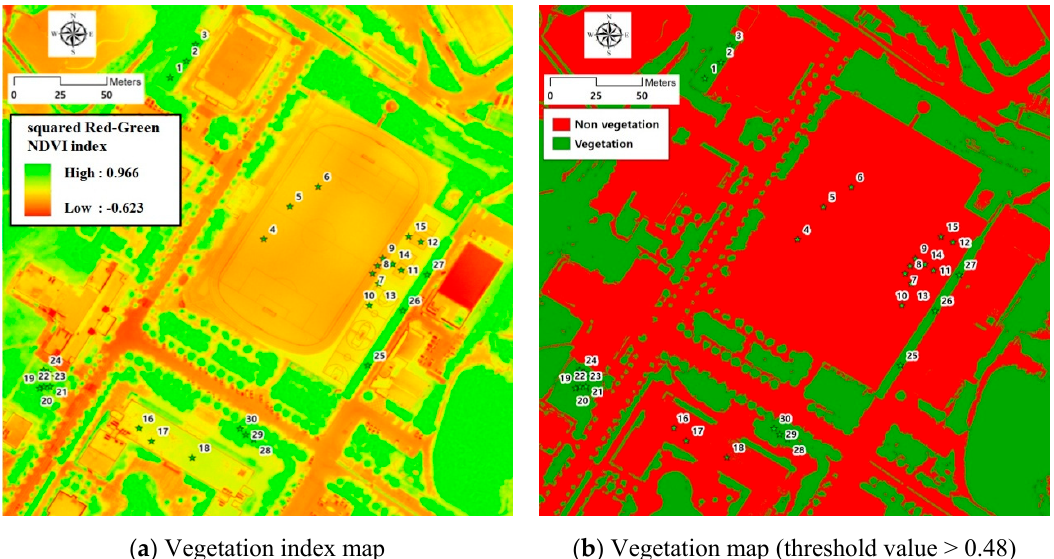
Figure 9. Vegetation index map and vegetation map based on the squared Red-Green NDVI index.